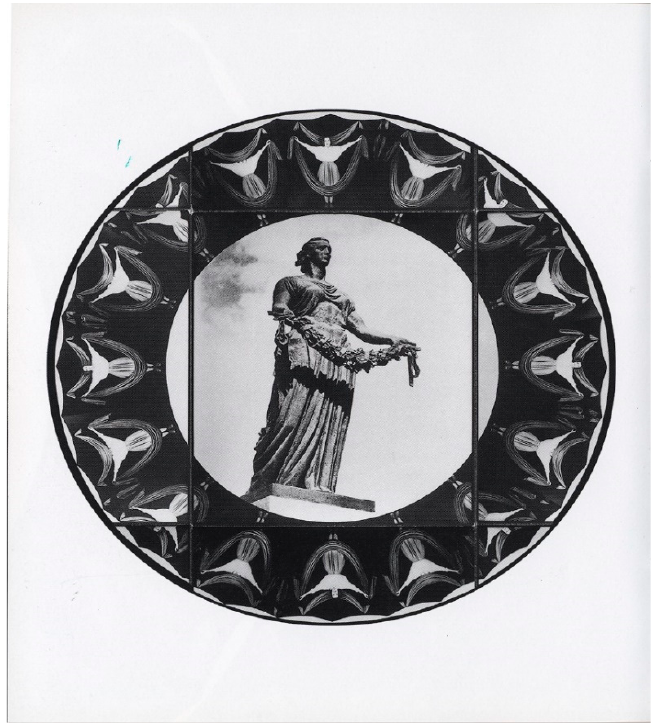
Figure 3. Kulik, guide , 1997. Lev Golovnitsky, Rear to the Front , 1979, Magnitogorsk.